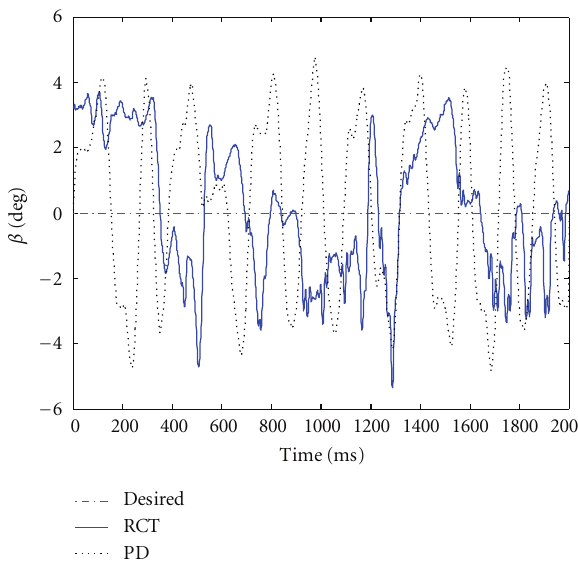
Figure 21: Lean angles of PD (black dotted line) and RCT control (blue solid